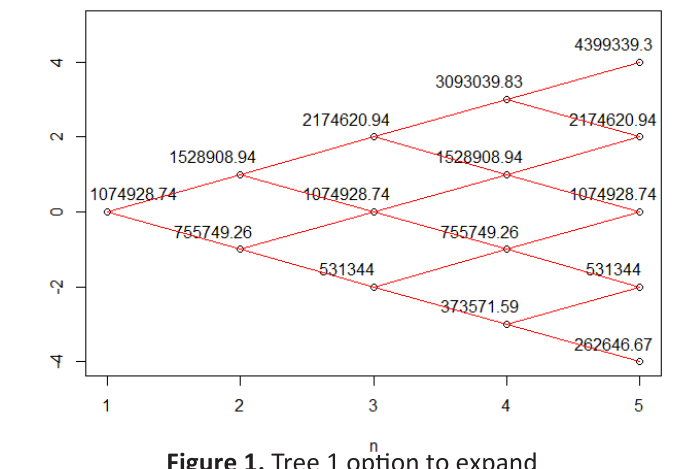
Figure 1. Tree 1 option to